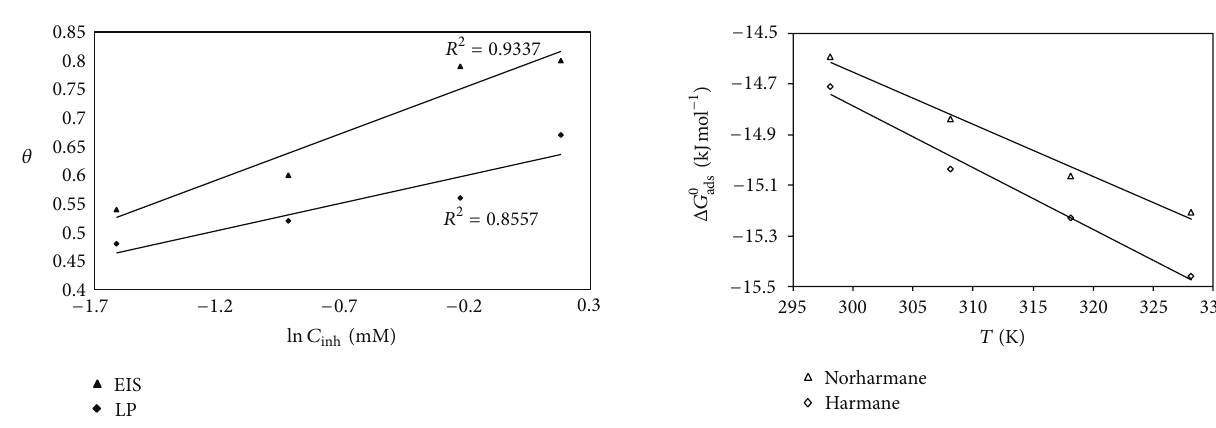
Figure 17: Temkin adsorption plots for C38 steel in 1M HCl containing different concentrations of norharmane at 55 ∘ C.